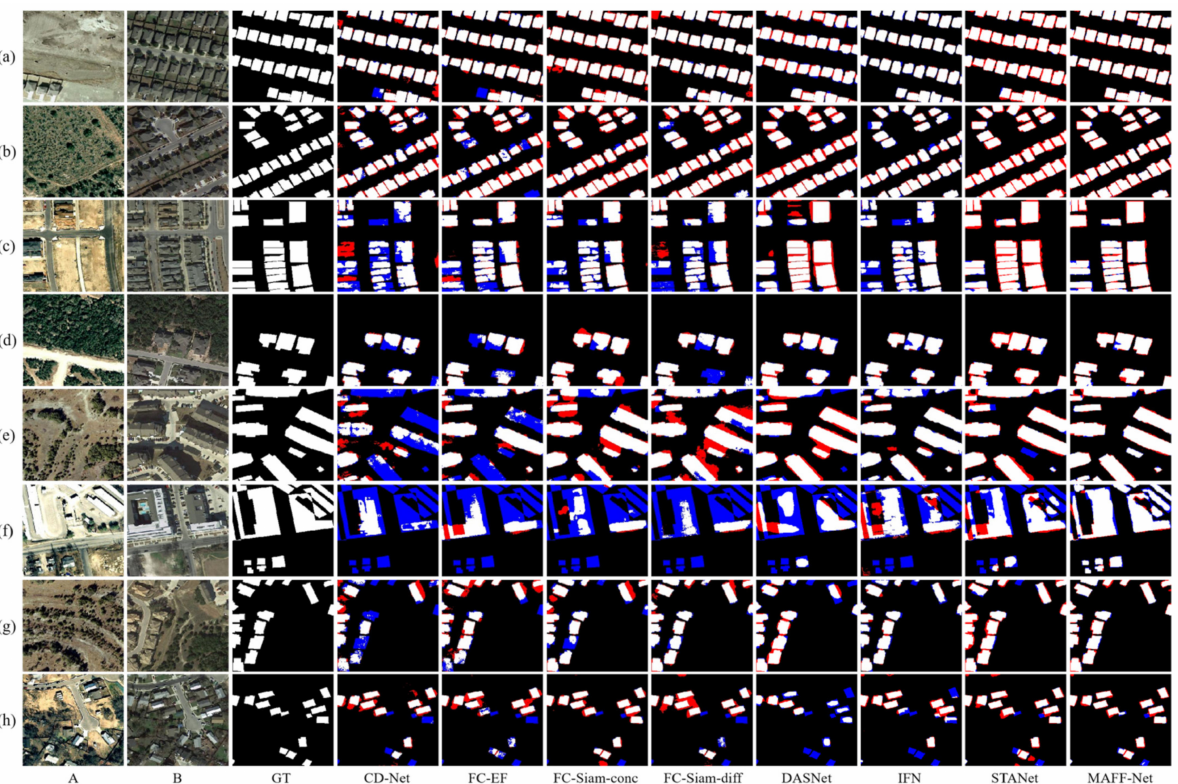
Figure 9. Illustration of a qualitative comparison on dataset LEVIR-CD. ( a – h ) indicate samples from LEV-IR-CD and the change maps obtained with different methods. The white color indicates the changes that were correctly detected. Black indicates that no changes have been correctly detected. Red indicates false alarms. Blue indicates unpredicted